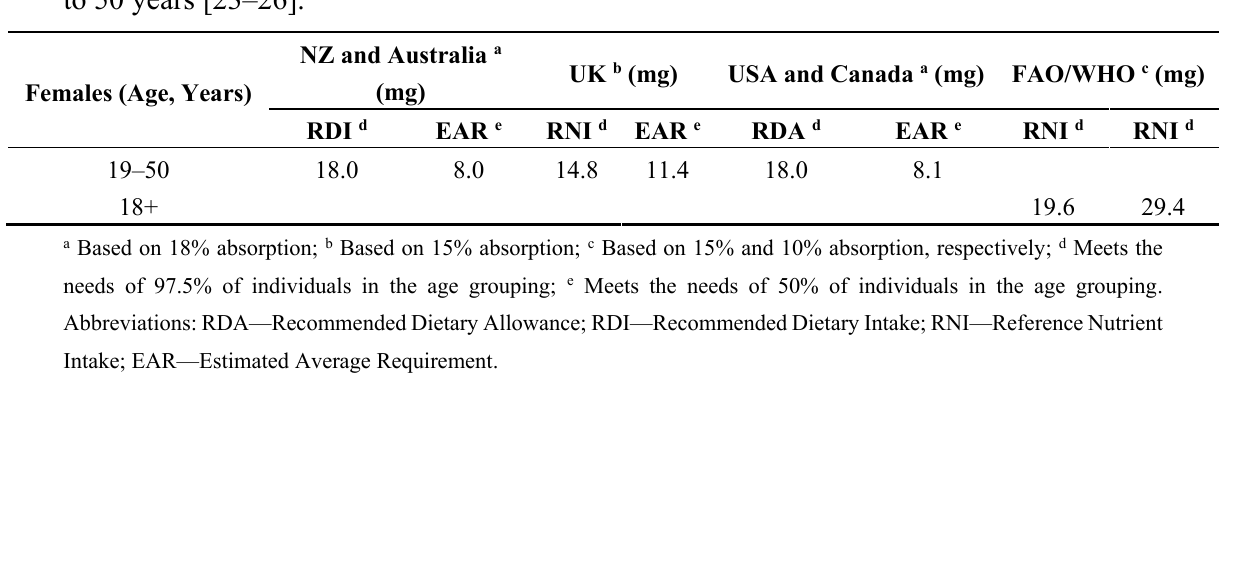
Table 2. Recommendations for iron intake for non-pregnant, non-lactating women aged 19 to 50 years